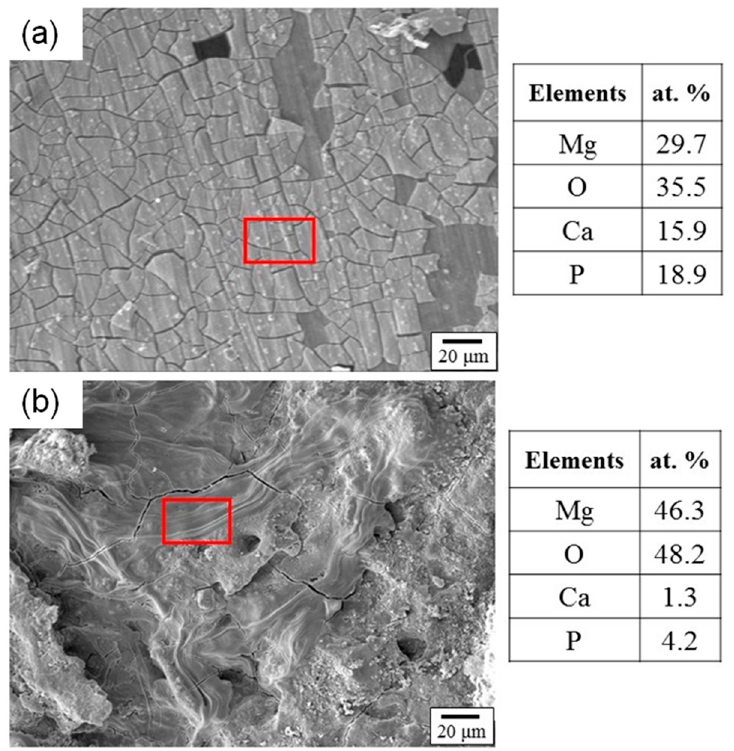
Figure 17. SEM images and EDS analysis of immersed surface. ( a ) XK105-H and ( b ) surface- roughened XK105-H.